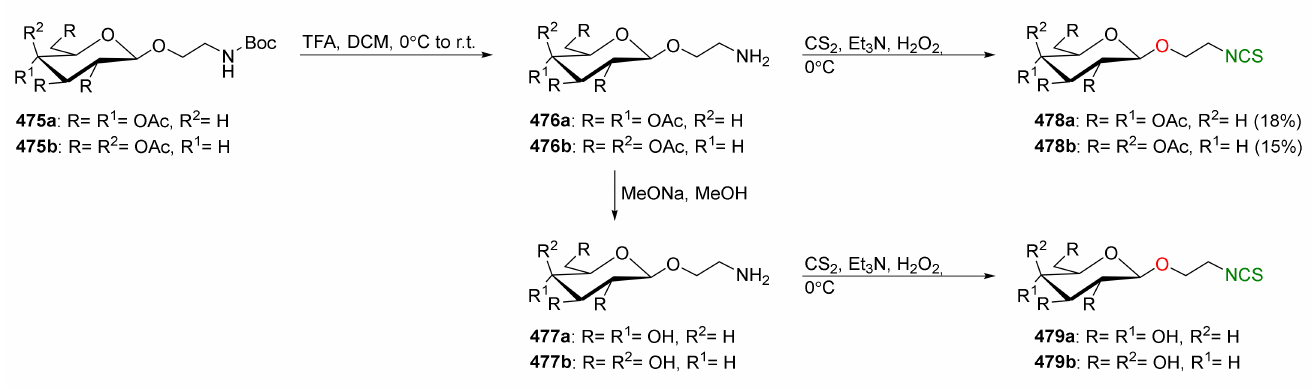
Figure 55. Synthesis of the target ITCs derivatives 478a – b and 479a – b .